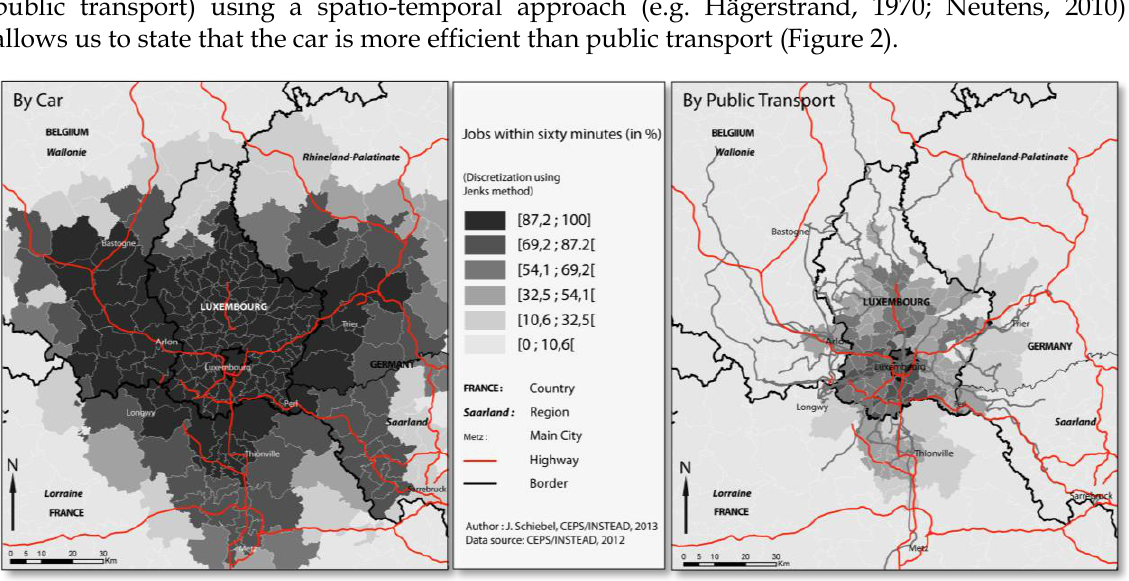
Figure 2. Access to the workplace in Luxembourg within 60 minutes during peak hours: comparison between car and public